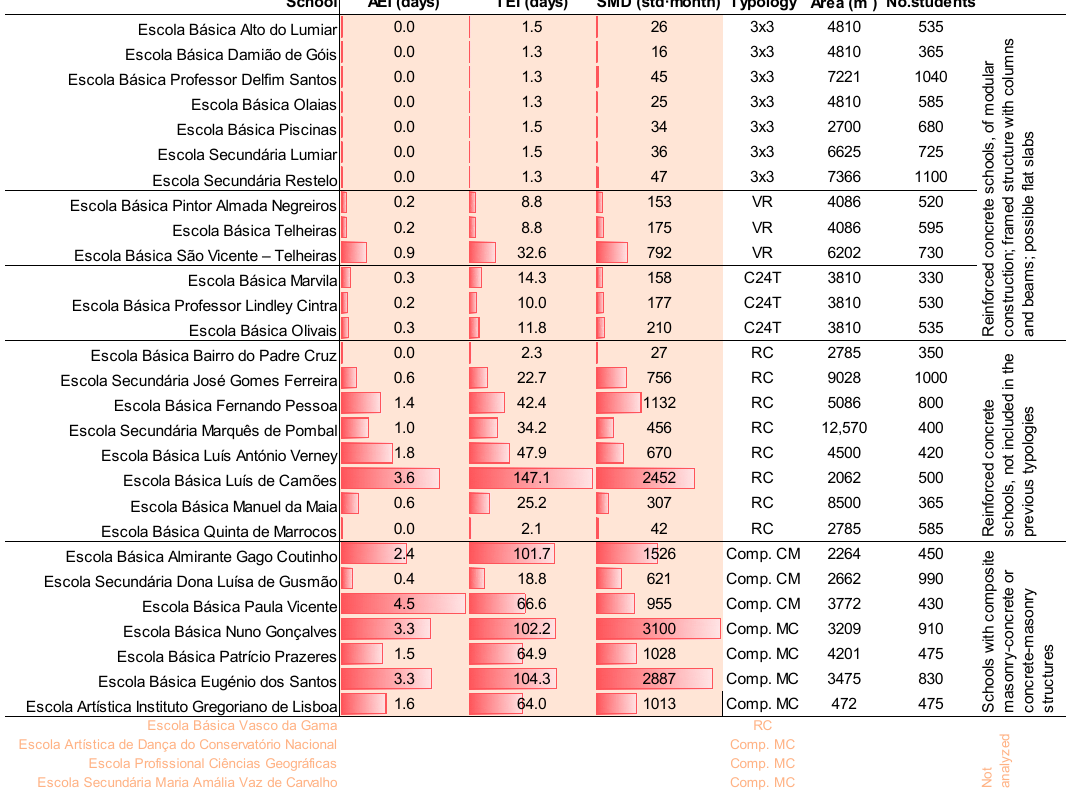
Figure 14. School ranking according to the number of interdiction days over 50 years.